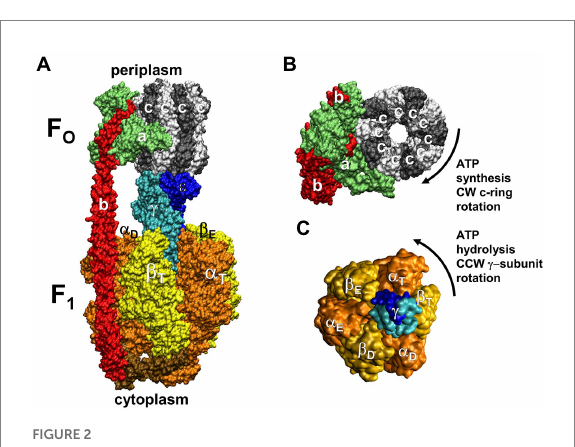
FIGURE 2 Subunit composition of Ec F 1 F O (pdb-ID 6OQR) from the side (A) , of F O from the periplasm (B) , and of solubilized F 1 (C) from the periplasm (pdb-ID 3OAA). Peripheral stalk, b-subunits; central stalk, γ – and ε –subunits; rotor subunits, γ –, ε –subunits and the c-ring; catalytic sites, β -subunits; proton-translocating half- channels, subunit-a. Each c-subunit carries one proton between subunit-a half-channels during